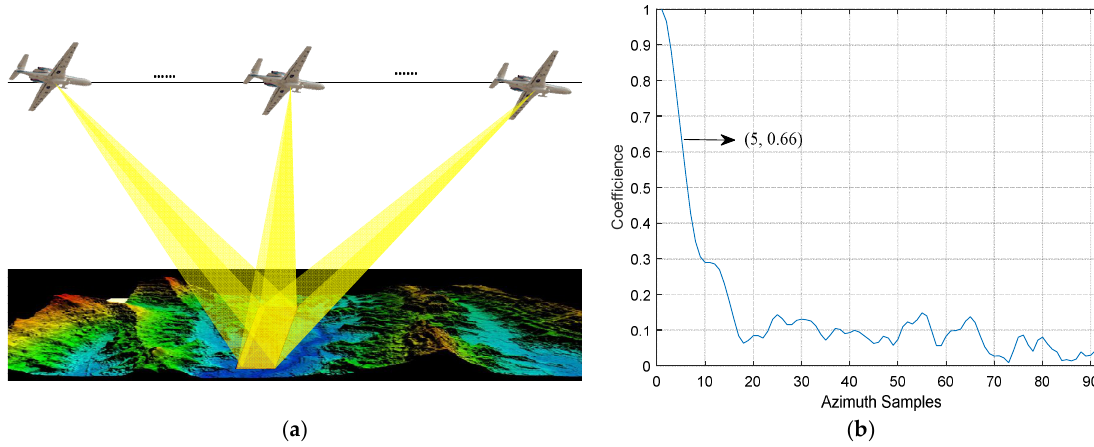
Figure 4. ( a ) MIMO-SAR beam developments for the proposed scheme. Instead of moving in accordance with the platform movement, the radar beams are focusing on the same scene during the whole synthetic aperture. ( b ) Channel responses coefficient of a typical airborne SAR scene for the beam development. In this case, if the waveforms are radiated every ten azimuth positions alone, the coefficient can be ensured higher than 0.66, namely, the channel responses of the ten adjacent azimuth positions are relevant.